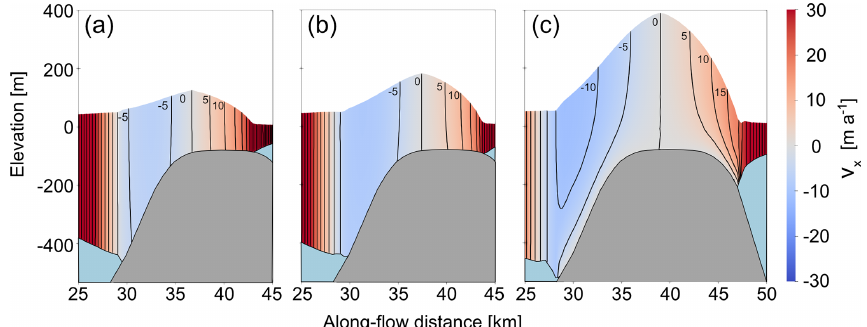
Figure 4. A cross-section of the ice rise in the along-flow direction for (a) the low-basal-friction, (b) the intermediate-basal-friction, and (c) the high-basal-friction scenarios. The contours show lines of equal velocity (full Stokes) in the x direction, i.e. in the along-flow